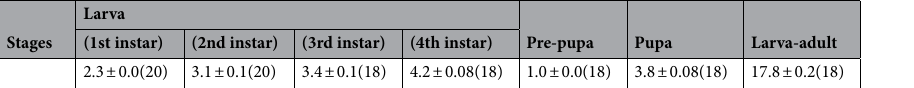
Table 2. Means (± SE) of duration (days) of immature stages of Eriopis connexa fed on Tetranychus evansi until the fourth instar, and with supplementary prey of Tetranychus urticae after the fourth instar , at 25 ± 1 °C, 70 ± 10% RH, and 12-h photoperiod. Numbers in parentheses: number of surviving specimens at each stage.